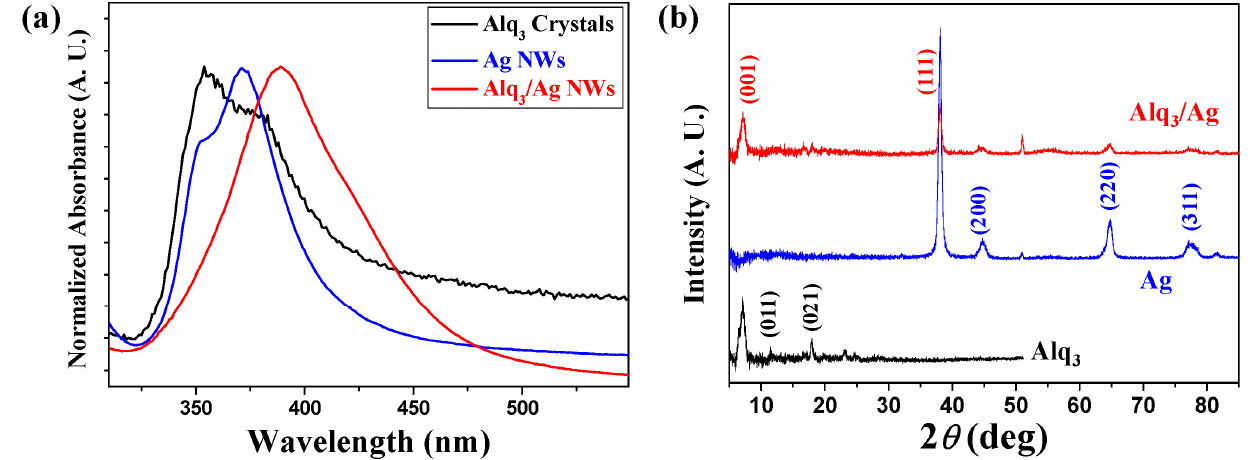
Figure 3. Comparison of the ( a ) UV absorption spectra and ( b ) XRD patterns of the pristine Alq 3 MRs (black), Ag NWs (blue), and hybrid Alq 3 /Ag NWs-MRs (red), respectively.